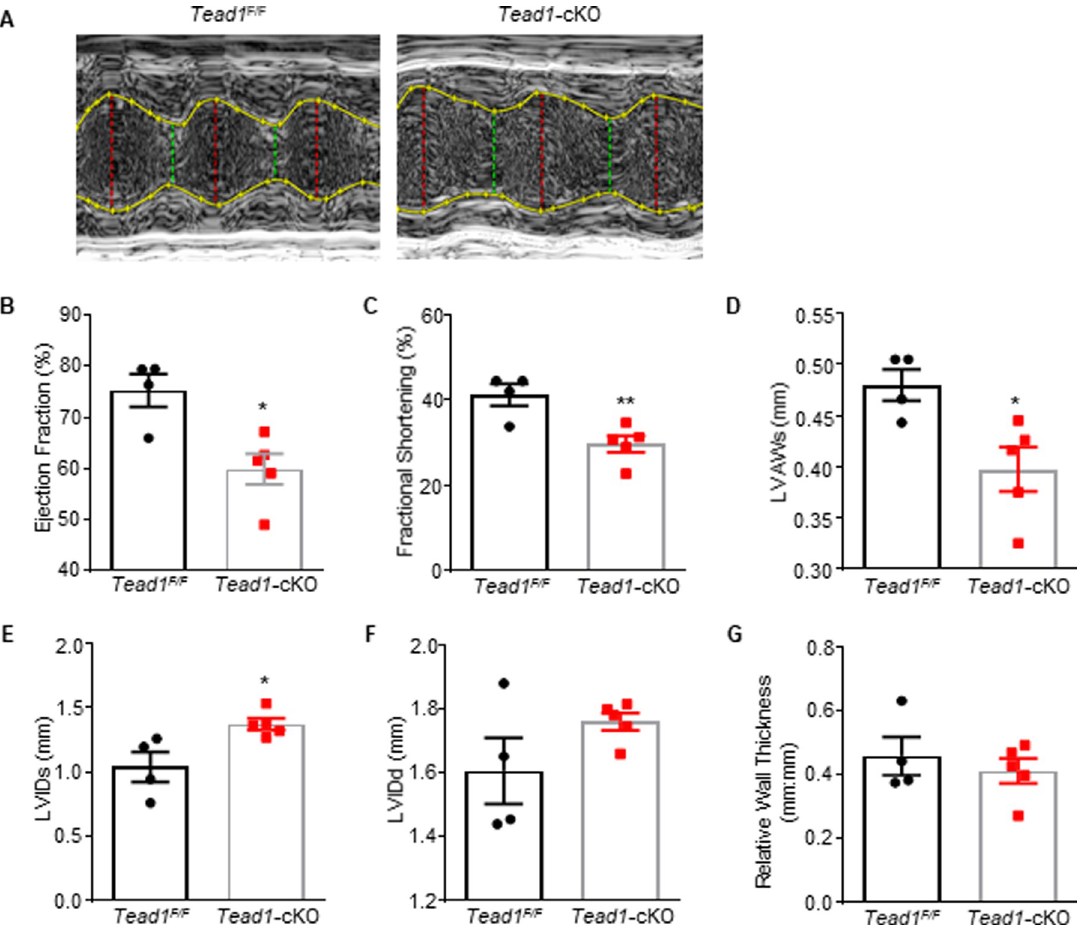
left ventricle internal diameter at systole and diastole (LVIDs and LVIDd), and ( G ) relative wall thickness (RWT, 2xLVPWd/LVIDd) of the Tead F/F and Tead1 -cKO pups (n = 4–5). �� p < 0.01, � p < 0.05; Student’s t